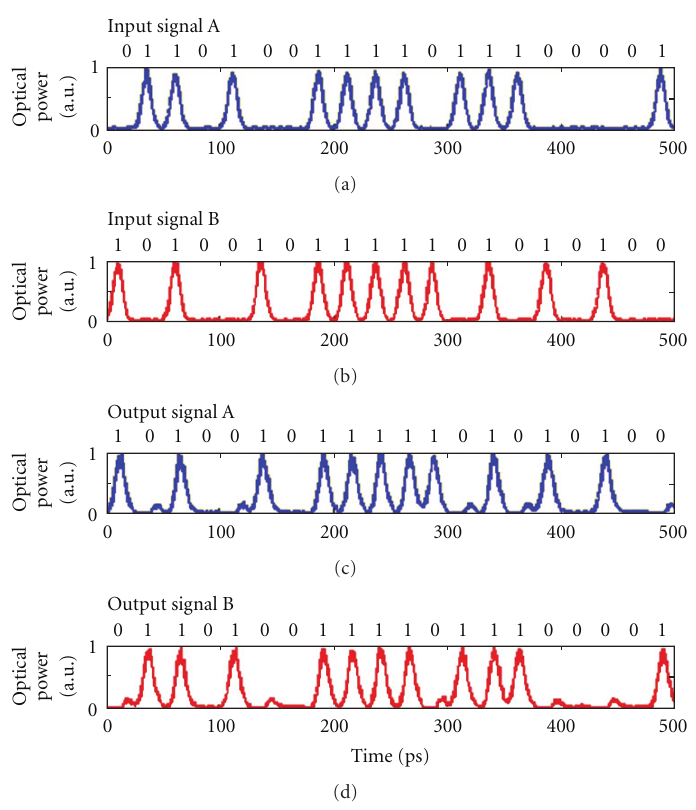
Figure 3: Simulation results of single-PPLN-based 40Gbit/s data exchange.